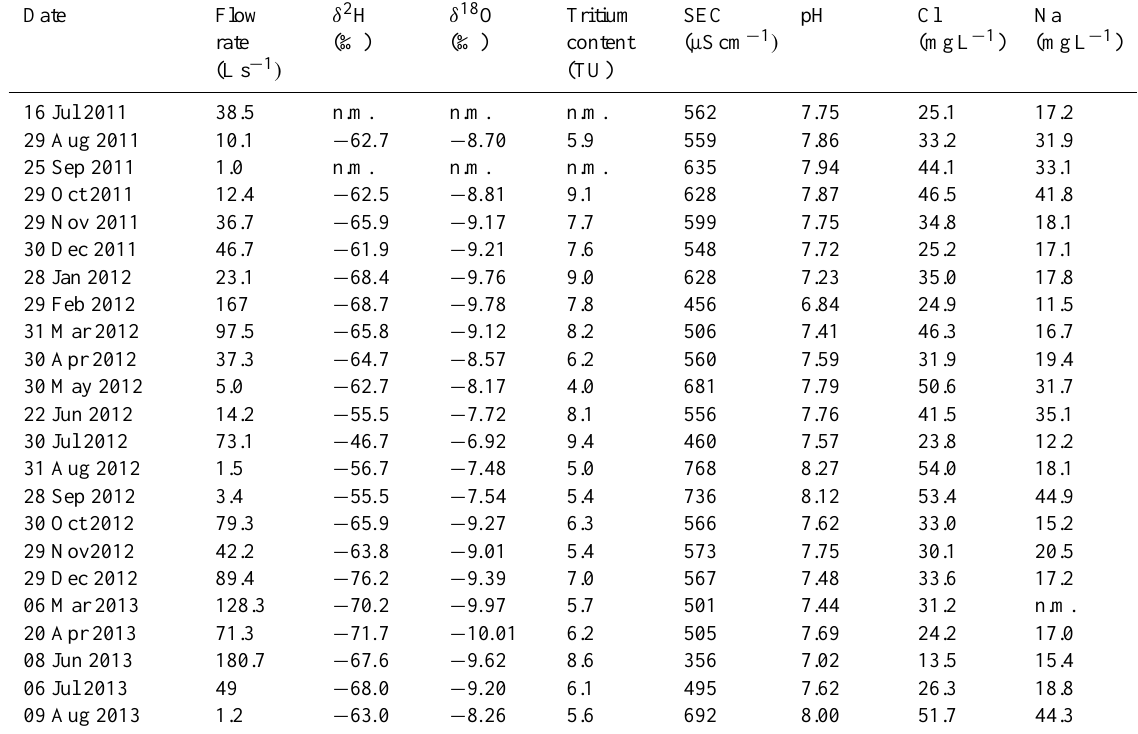
Table 4. Physico-chemical parameters of Dluga Woda stream monitored on a monthly basis during the period August 2011–August 2013 (n.m.: not